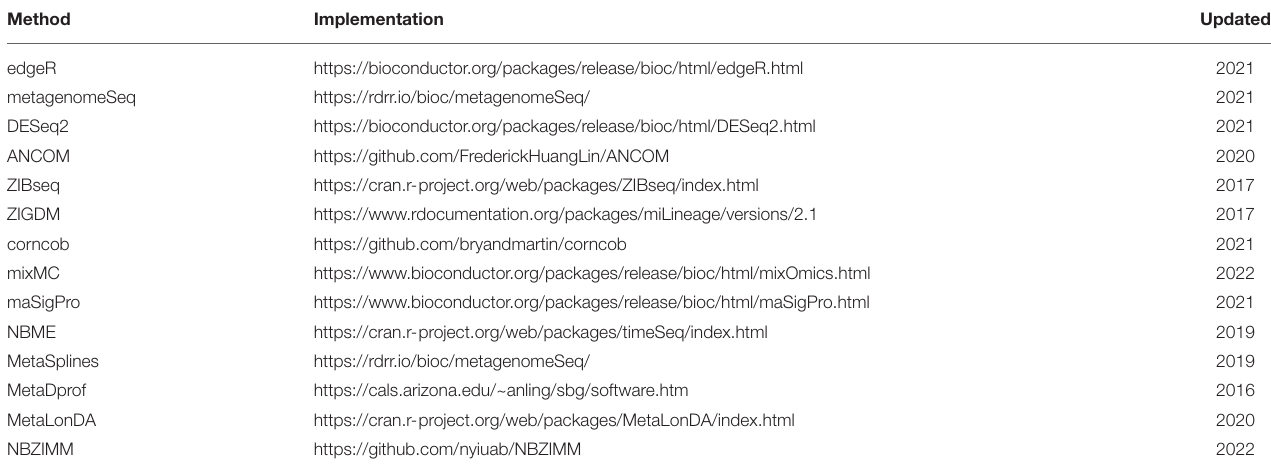
TABLE 4 | Implementation in R for differential abundance analysis in microbiome